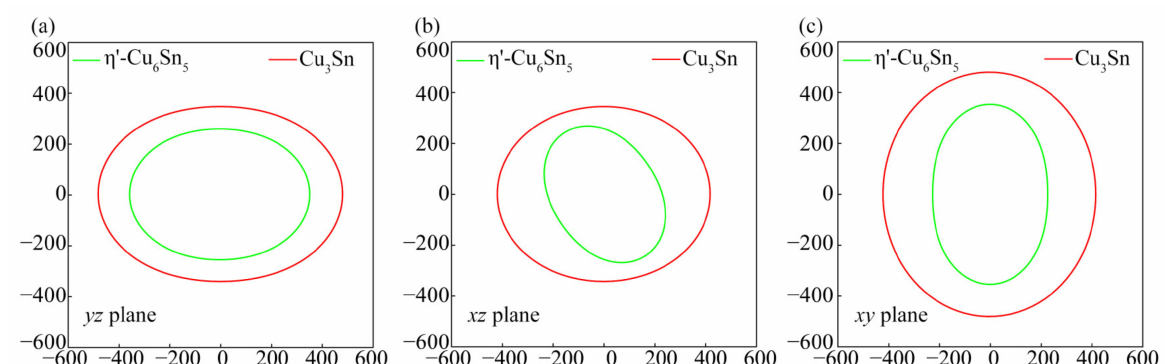
Figure 7. Cross-sections of B in the yz , xz , and xy planes for η (cid:48) -Cu 6 Sn 5 and Cu 3 Sn: ( a ) the yz plane; ( b ) the xz plane; ( c ) the xy plane. The green and red lines denote the cross-sections of η (cid:48) -Cu 6 Sn 5 and Cu 3 Sn,